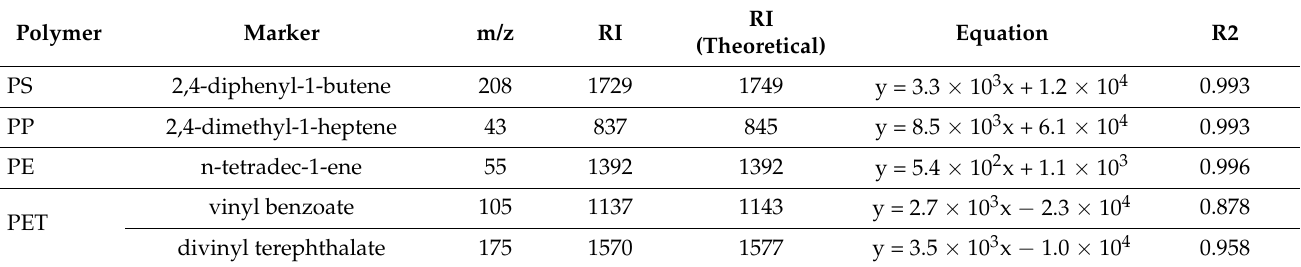
Table 3. Py-GC-MS calibration information for individual PP, PE, PS, and